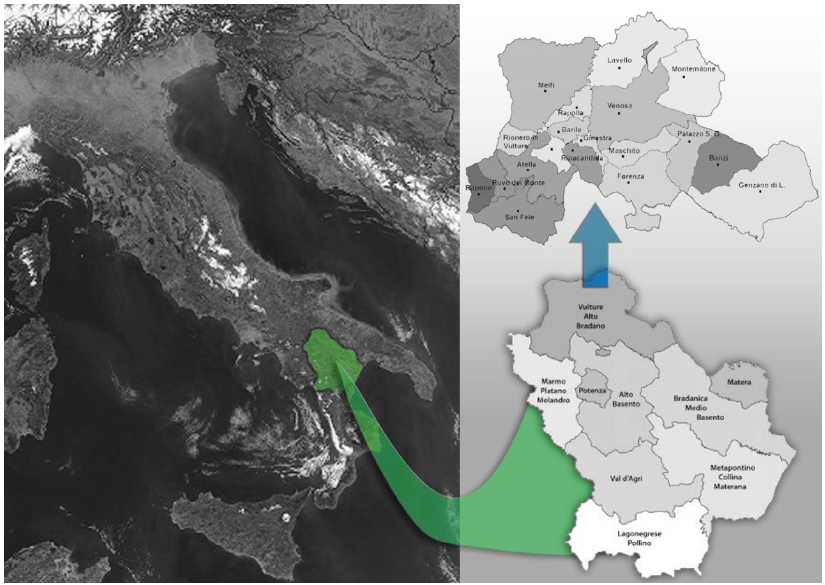
Figure 1. Study area location: Italy, the Basilicata region and the Vulture Alto-Bradano area.